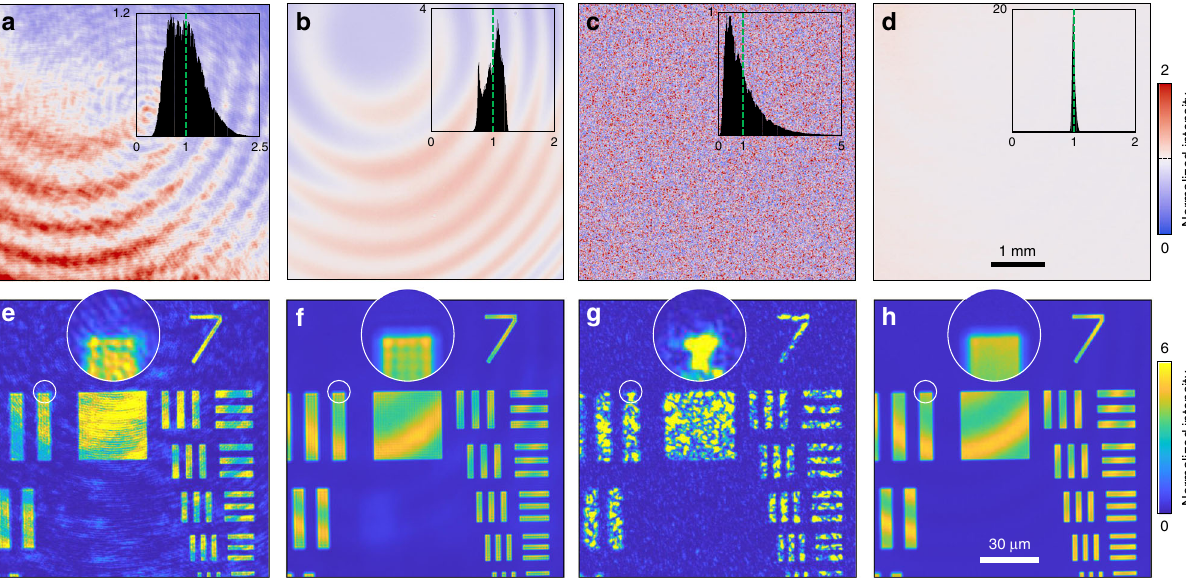
Fig. 5 Spatial properties. For each pair, a conventional laser (left) and the proposed laser (right) were used. a , b Direct beam images without a diffuser. c , d Direct beam images with a diffuser. The insets are the probability density functions of the corresponding images. The x -axis is normalized to the mean value (green dotted line). e , f 1951 USAF resolution target images without a diffuser. g , h 1951 USAF resolution target images with a diffuser in front of the target. See ‘ Methods ’ for the details of the optical